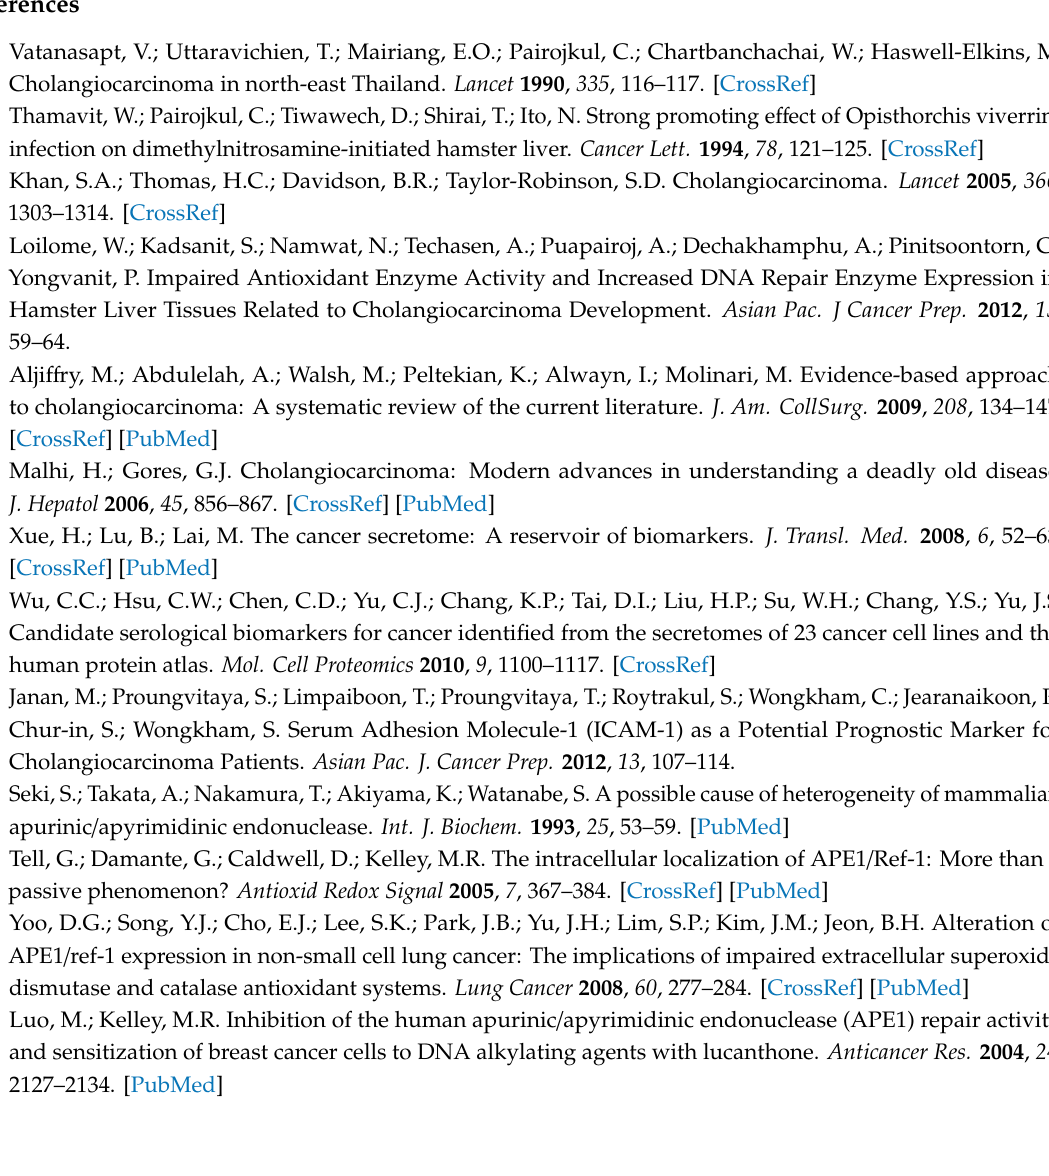
Figure S1: Shu ffl ing and randomization of serum samples, Figure S2: Validation of the accuracy of dot blot quantification. Table S1: The relative expression level of 90 distinct proteins found in the secretome of three CCA cell